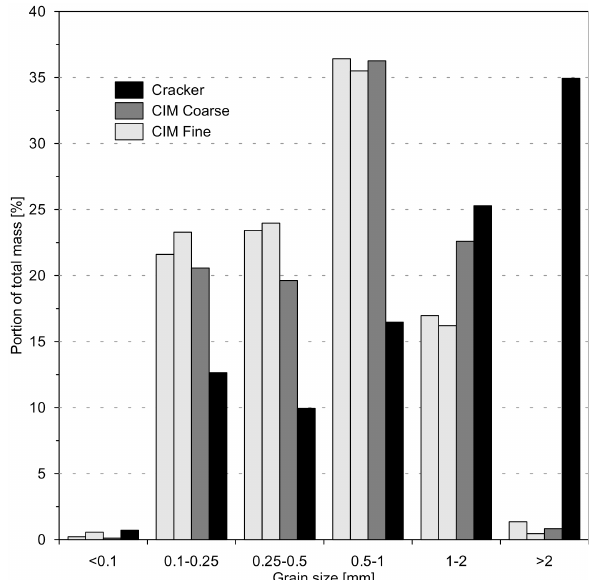
Fig. 3. Grain size distribution of the ice powder produced with the cracker and CIM used in our lab. The height of the bars represents the percentage of the total powder mass found in a specific grain size range. The black bars indicate powder from the cracker (total mass: 16g), the grey bars from the CIM with two different knife positions producing coarser (dark grey) and finer (light grey) powder. With the fine setup two experiments have been performed (total mass for each CIM experiment: